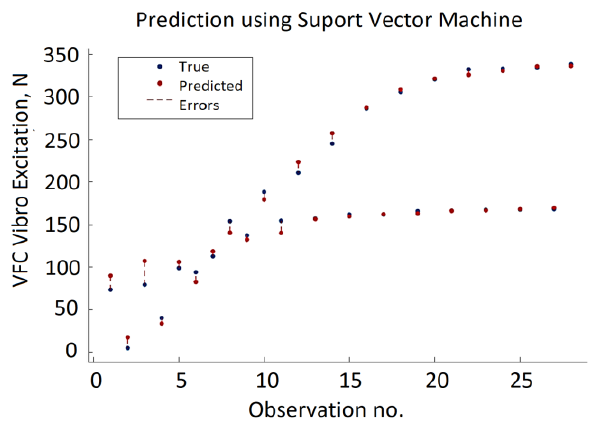
Figure 11. Testing data results of the SVM model.